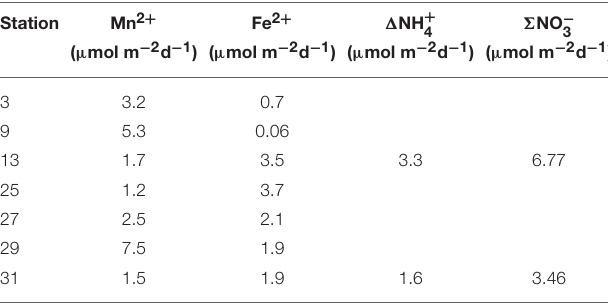
For Fe +2 and Mn +2 , the flux was calculated at the depth indicated by the black arrows on Figure 2 . 1 NH + 4 iscalculatedasthedifferenceinthefluxaboveandbelowthisdepth(below-above) forstationswithanobservablechangeinthegradient. Σ NO − 3 isthesumoftheproduction and consumption of the secondary NO − 3 peak.